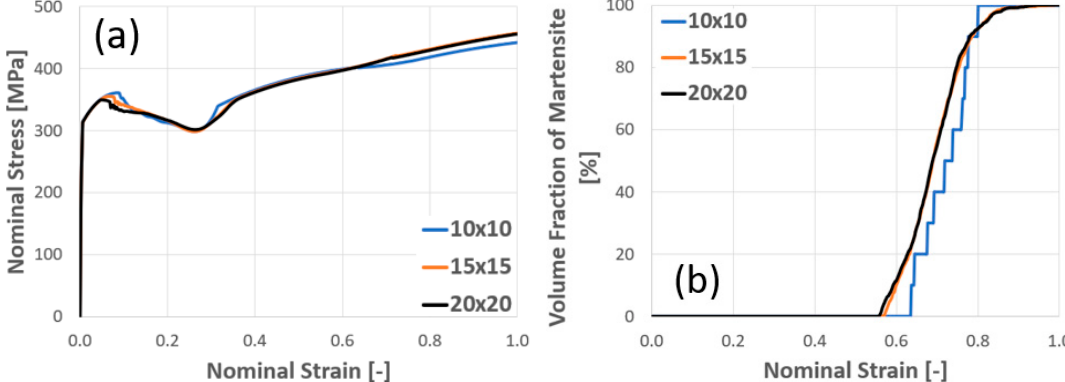
Figure 16. The dependence of mesh refinement in single crystal ( a ) Nominal stress versus nominal strain and ( b ) the volume fraction of martensite versus nominal strain.